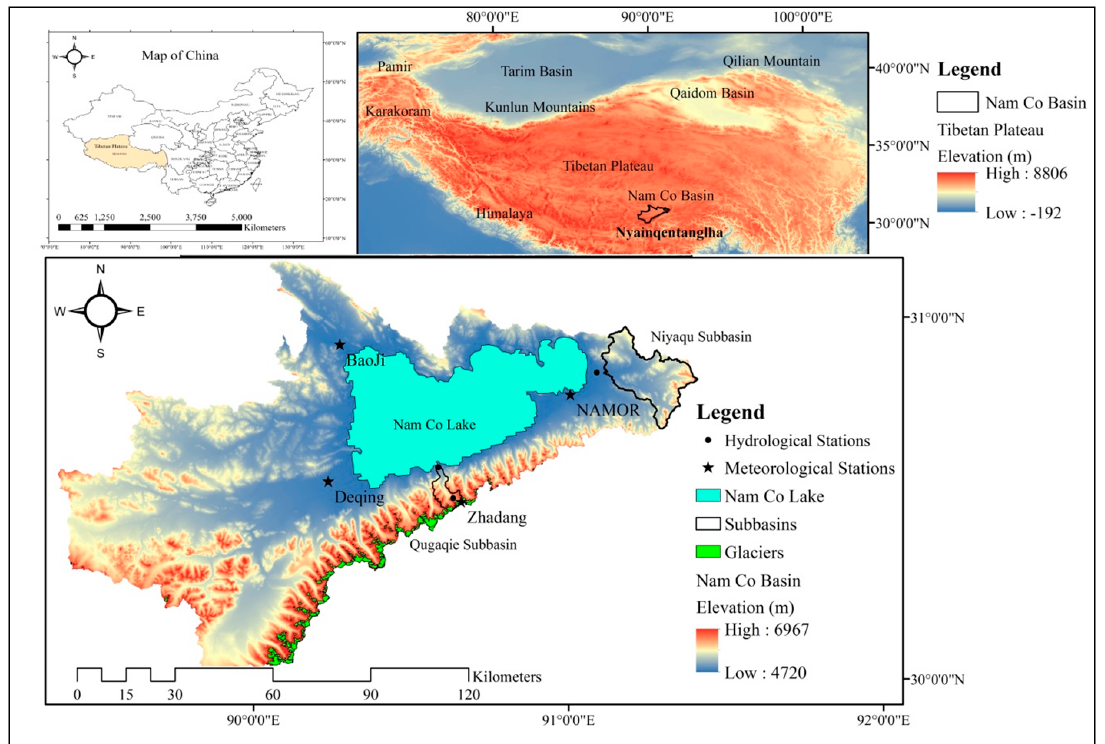
Figure 1. Geographical map of the study area and automatic hydro-meteorological stations.